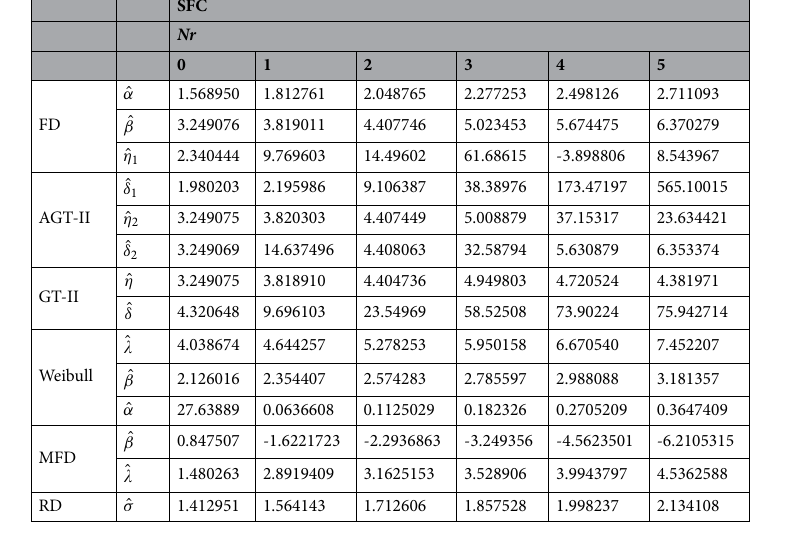
Table 2. Estimates of the parameters of statistical distribution for SFC.